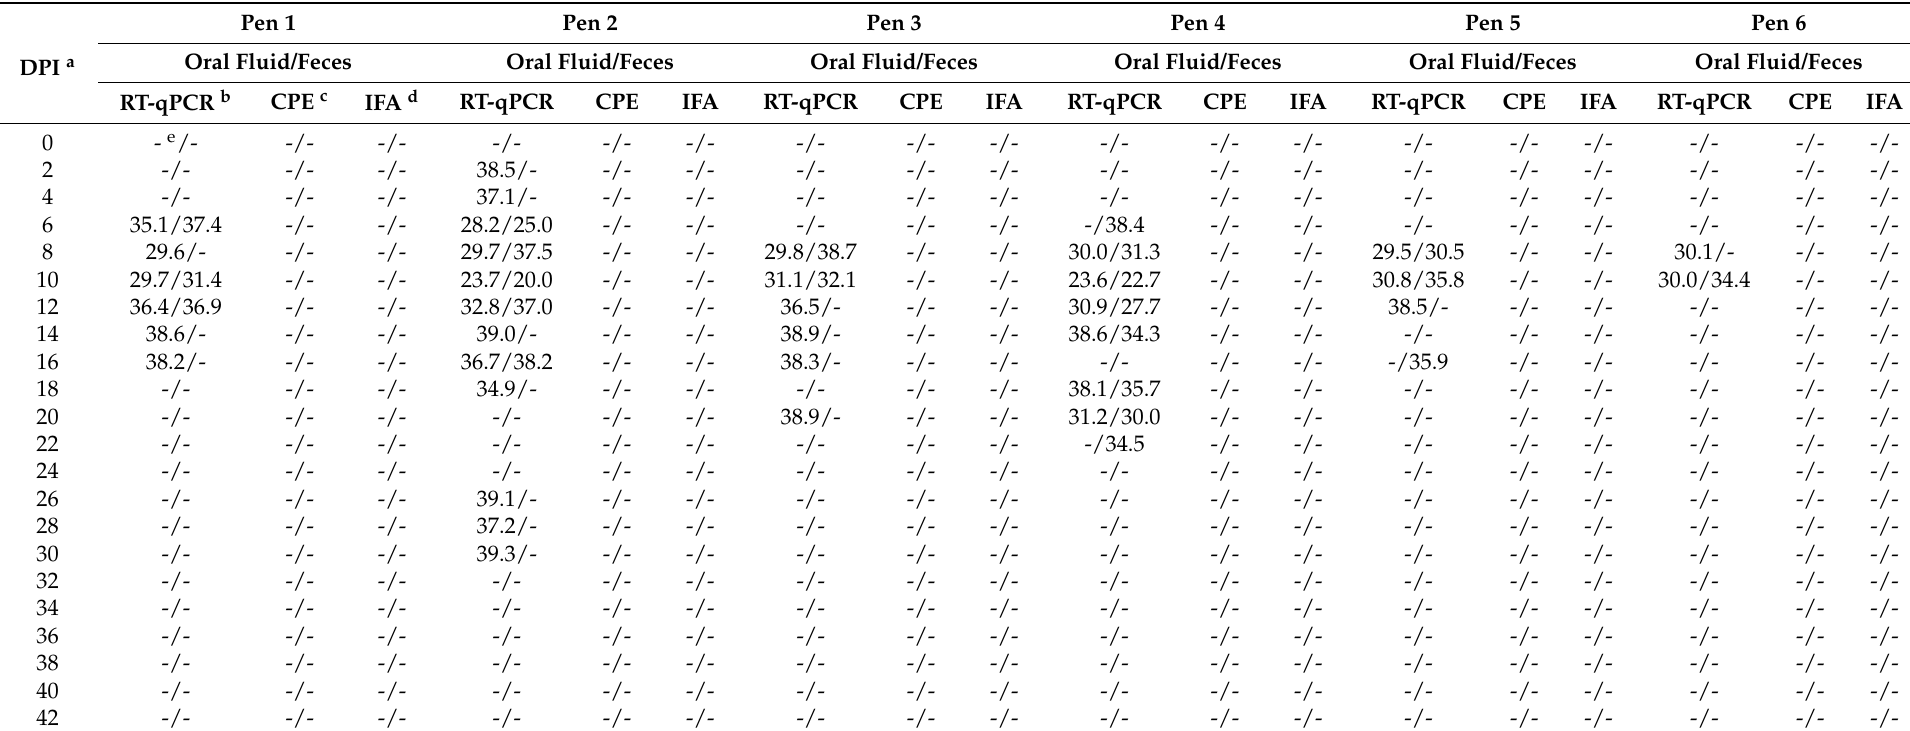
Table 1. Detection of porcine deltacoronavirus (PDCoV) RNA (RT-qPCR Ct values) in pen-based oral fluid and feces following PDCoV-inoculation and in